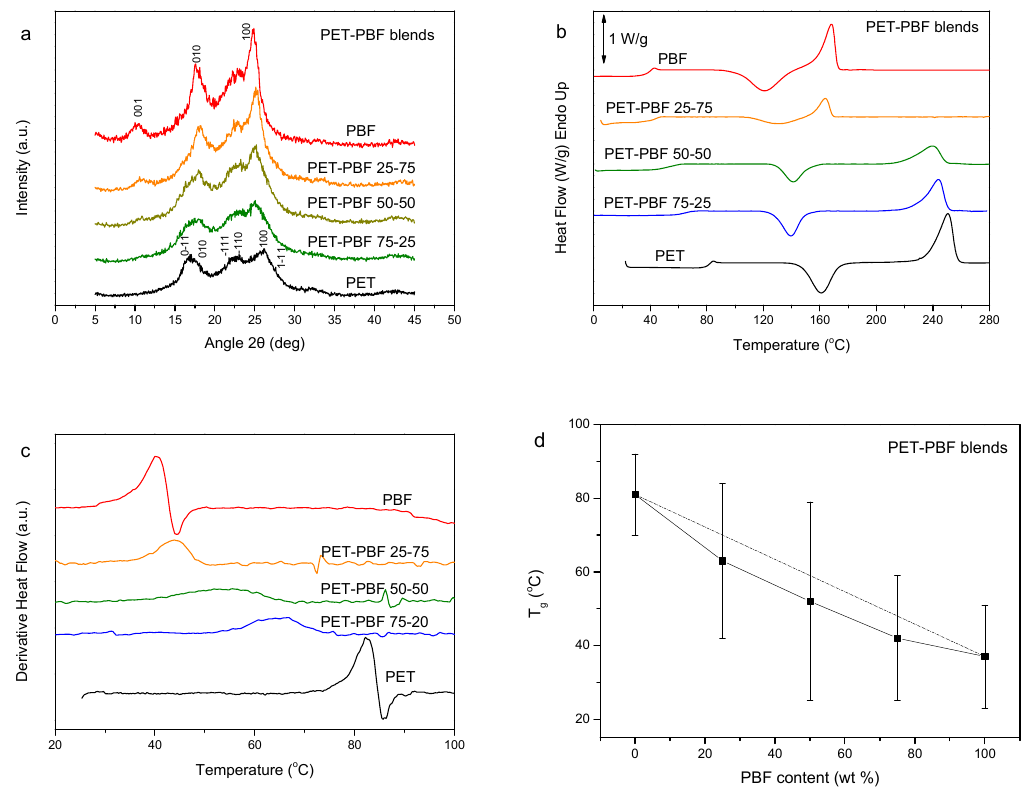
Figure 3. ( a ) WAXD patterns, ( b ) DSC traces of the melt-quenched samples upon heating, ( c ) derivative heat flow thermograms, and ( d ) variation of T g and glass transition width with PBF content, for the poly(ethylene terephthalate) (PET)–PBF blends.